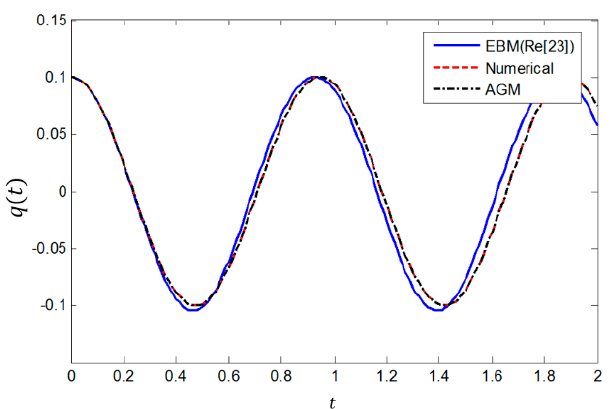
Figure 5. Result comparison between AGM, EBM, and numerical solution for case study 2 (a = 48.0611, b = − 543.1630,c = − 2223.874, pl